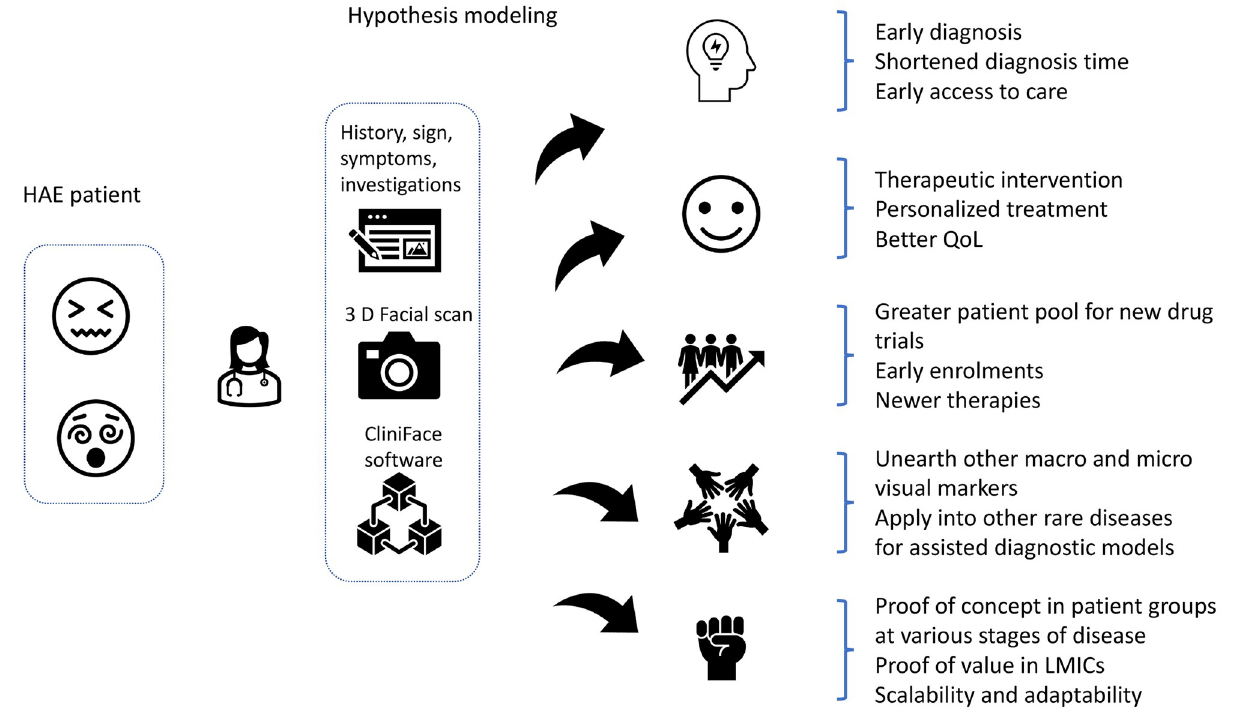
Fig 5. Hypothesis benefit model in HAE patients with 3 D facial scan and Cliniface